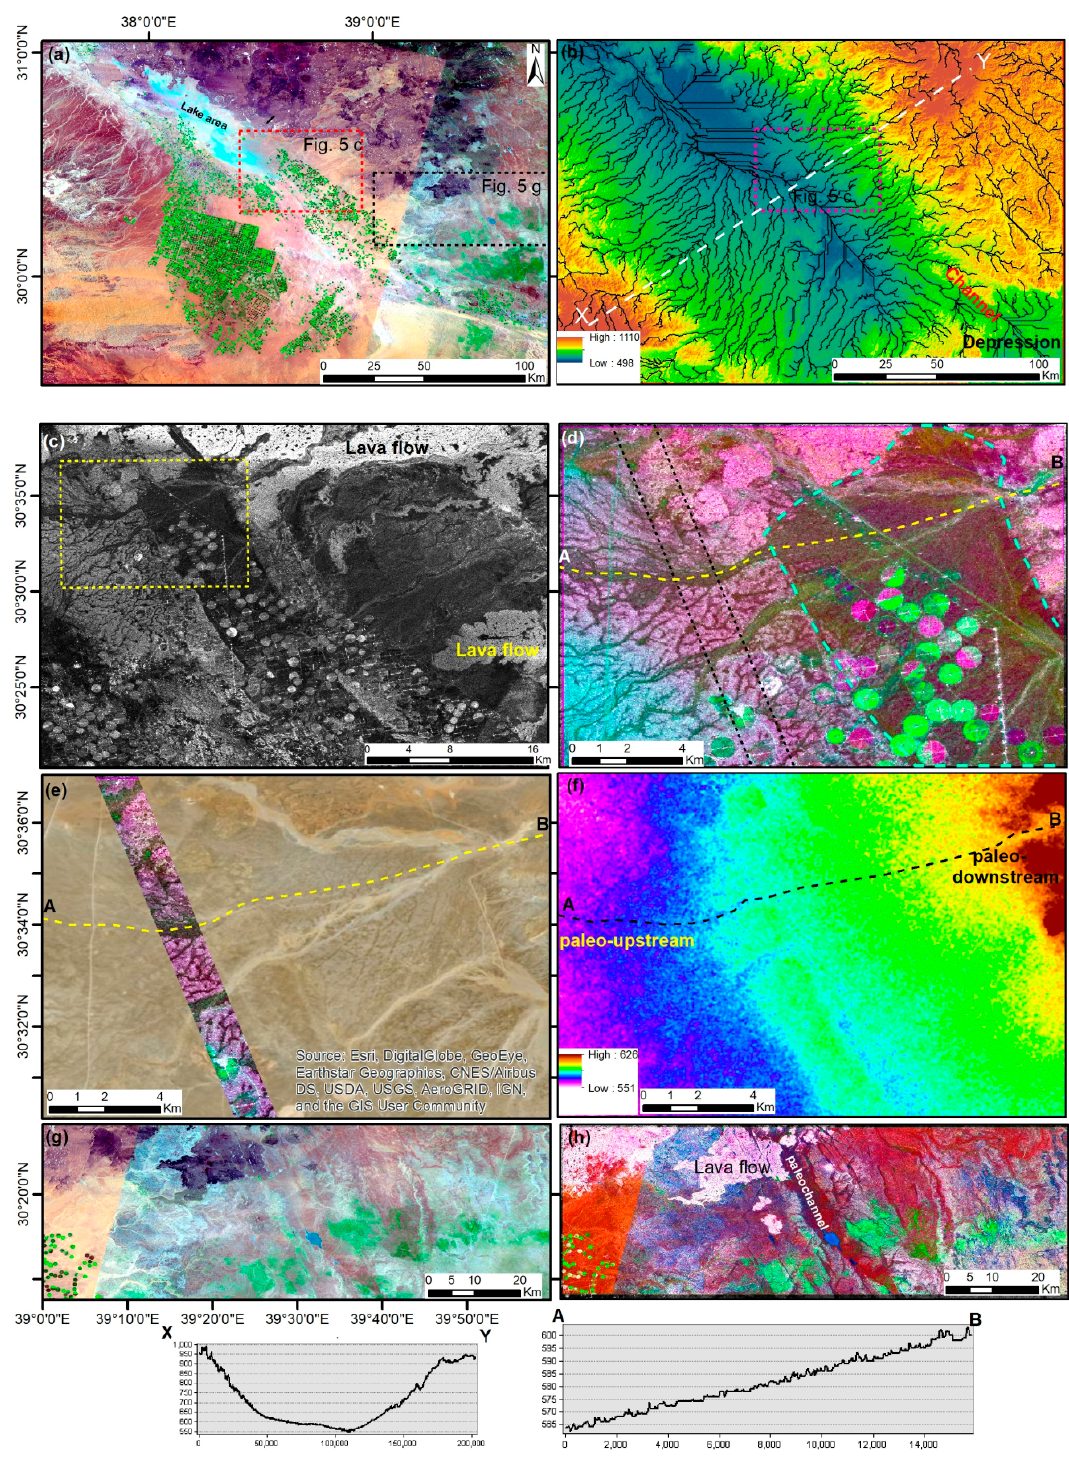
Figure 5. The Al Jouf (Wadi Sirhan) area, denoted by the yellow box in Figure 1. ( a ) A Landsat OLI color composite (bands 7, 5, and 3) covering an area in northeast Saudi Arabia showing the land cover of vegetation, sand deposits, and rock units west of Al Jouf (Wadi Sirhan). Note the existence of the elongated a probable lake ‐ like area that is marked in cyan. The red box refers to Figure 5c, while the black box refers to Figure 5g,h. ( b ) The SRTM DEM, at a resolution of ~30 m, with the extracted stream networks overlaid. The low topographic areas are in dark blue. The lake ‐ like area is depicted by the X–Y profile. ( c ) Subset of ALOS/PALSAR image view, as indicated in Figure 5a,b; the circular features represent vegetated areas, while the bright ‐ toned blocks represent lava flow. ( d ) Close ‐ up view of ALOS/PALSAR, as indicated by the yellow dashed polygon in Figure 5c; the area between the two parallel dashed black lines is shown in Figure 5e; the rectangular area is marked by a dashed cyan line. The dashed yellow line is a trace of a paleochannel. ( e ) Geo ‐ Eye/Digital Globe data overlaid with the A–B profile and fused section of the ALOS/PALSAR and Landsat OLI; the profile A ‐ B across the paleostream indicates its topography. Light tone displays the paleochannel extension. ( f ) SRTM DEM (30 m) displays the maximum elevation to east that decreases westward as indicated in profile A–B. ( g ) Close ‐ up view of Landsat ‐ 8 as indicated by the black polygon in Figure 5a; lava flows are represented by dark brownish black color located in the northwest of this Figure 5g. ( h ) Subset of combined ALOS/PALSAR and Landsat OLI data displaying the paleochannel that has been obscured by sand and vegetation as in Landsat OLI in Figure 5g; bodies of water are displayed in blue and lava flows are displayed in white tone to north. The paleochannel probably drained northward but lava flow blocked it in the north.